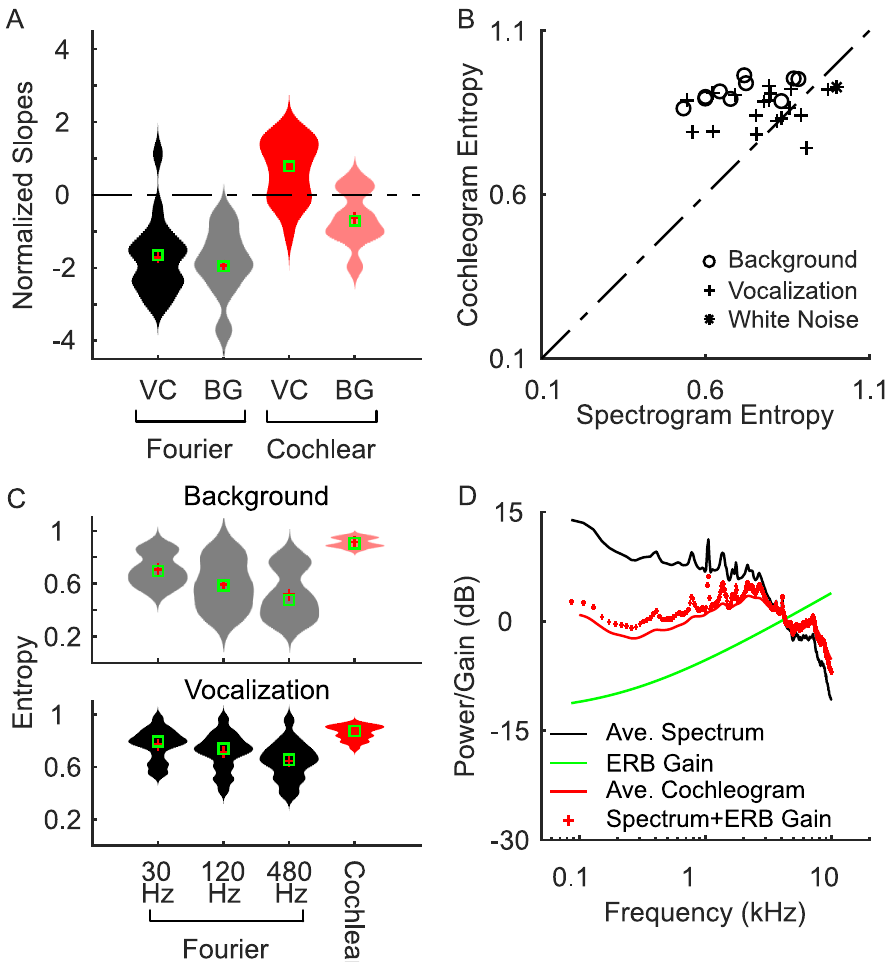
Fig 5. Cochlear model bandwidth scaling whitens the power spectrum of natural sounds and maximizes spectral entropy. (A) Violin plots showing the distribution of normalized slopes of the best regression fits to both the Fourier and cochlear models (from Fig 4). For both vocalization and background sounds, normalized spectral slopes for the Fourier decomposition are negative and not significantly different (t-test, p = 0.58). By comparison, vocalizations have positive and negative slopes for vocalizations and background sounds, respectively, with an average slope near zero (0.2) indicating a whitened average spectrum. (B and C) The cochlear model entropy is higher than Fourier-based entropy regardless of the Fourier filter resolution used (30, 120 or 480 Hz). (D) Bandwidth scaling predicts the cochlear filter whitening. The average Fourier power spectrum has a decreasing trend (black) whereas the cochlear power spectrum is substantially flatter (red, continuous). The gain provided by the cochlear filter bandwidths (green curve) increases and counteracts the decreasing power trend of the Fourier power spectrum. The cochlear power spectrum is accurately predicted by considering the bandwidth dependent gain (dotted red lines; bandwidth gain + Fourier power